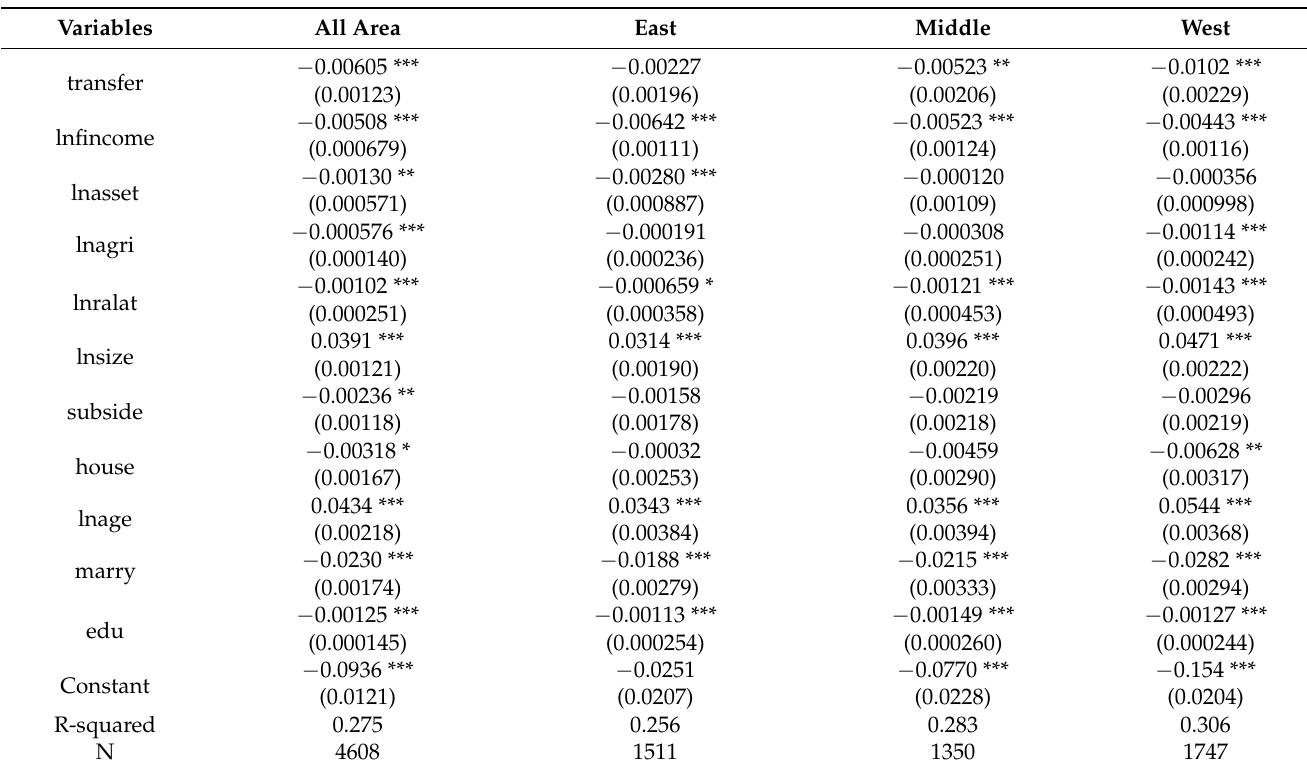
Table 2. Baseline regression and sub-regional regression